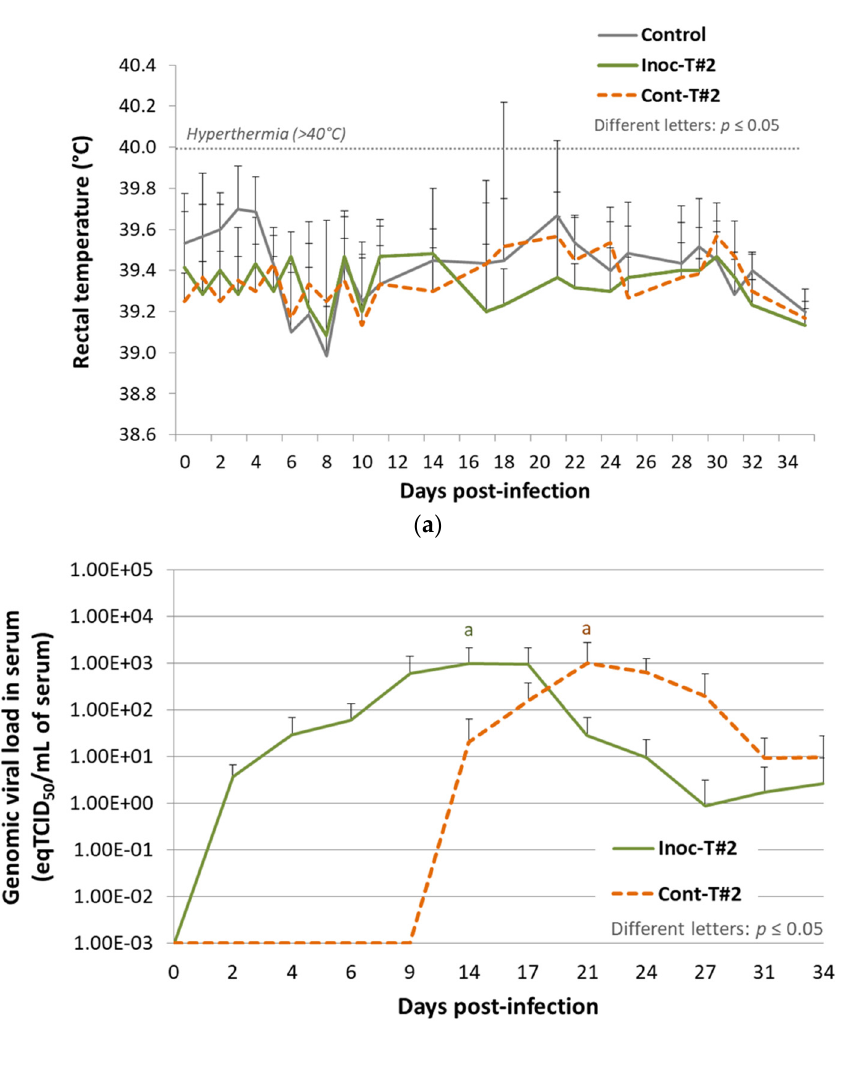
Figure 3. Results from Trial#2. ( a ) Evolution of the mean rectal temperatures (°C) in Inoc-T#2 inoculated pigs and in Cont-T#2 contact pigs after inoculation (day 0). Different letters indicate that the groups are significantly different from each other with p ≤ 0.05. ( b ) Evolution of the mean genomic viral loads in serum (eqTCID 50 /mL of serum) in Inoc-T#2 inoculated pigs and in Cont-T#2 contact pigs after inoculation (day 0). Different letters indicate that the groups are significantly different at peak values from each other with p ≤ 0.05.